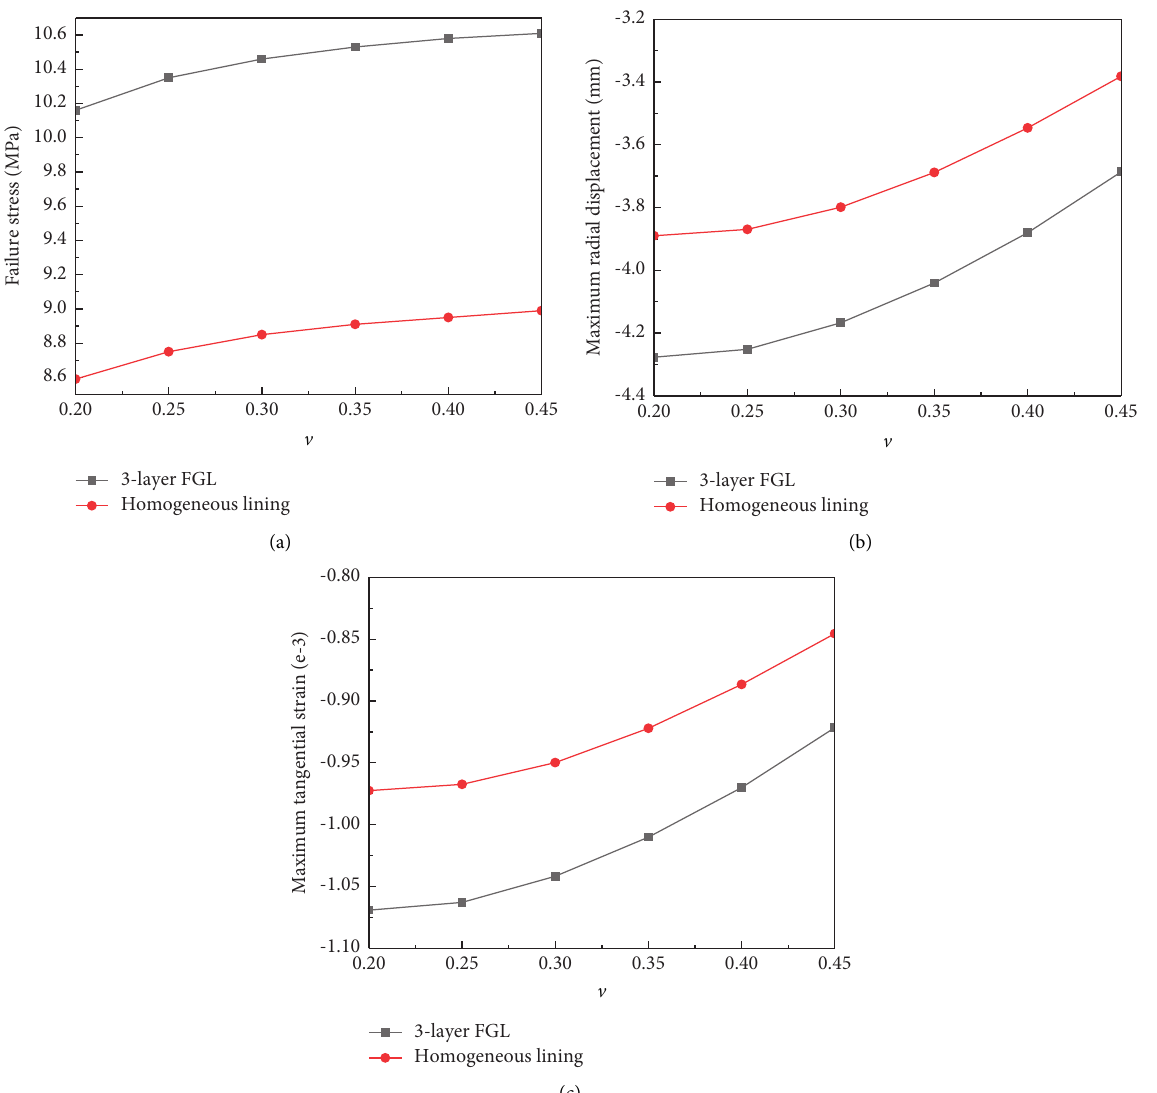
Figure 14: Variations in ultimate bearing capacity, maximum radial displacement, and maximum tangential strain with Poisson’s ratio of concrete ] . (a) Ultimate bearing capacity. (b) Maximum radial displacement. (c) Maximum tangential